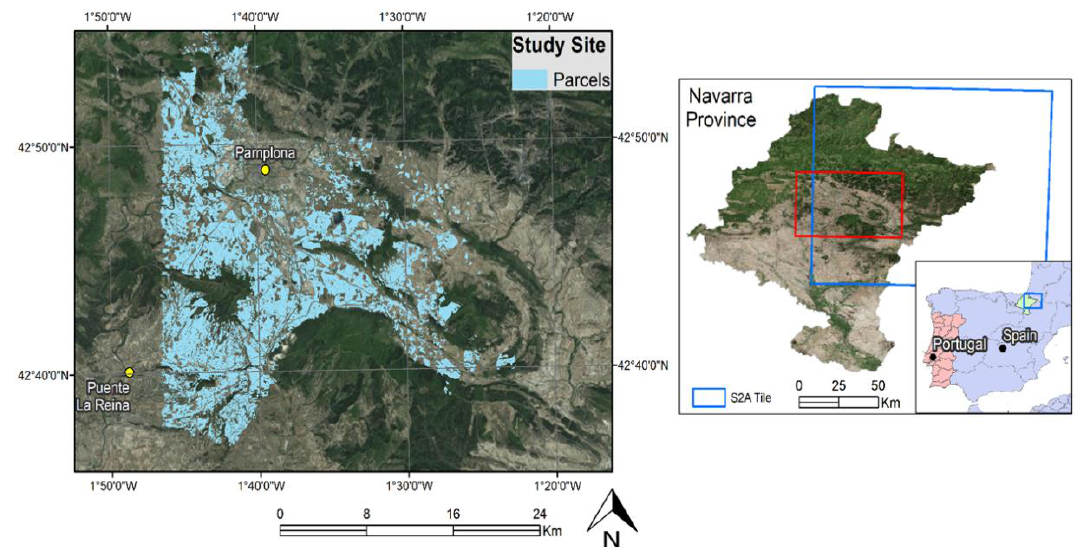
Figure 1. Study area located in the Spanish province of Navarra and the corresponding Sentinel-2A tile (S2A tile) covering it. The site refers to the agricultural zone surrounding the city of Pamplona.